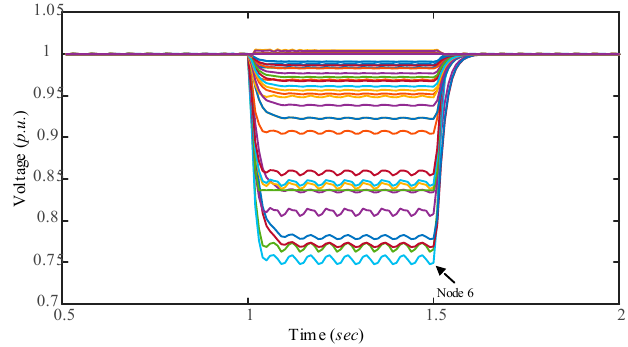
Figure A3. Voltage drop curve of nodes when node 6 fails.